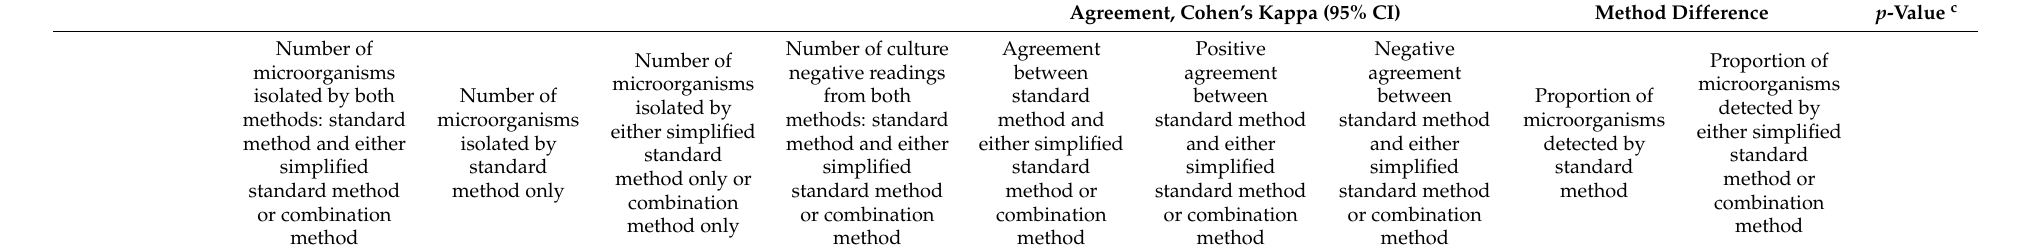
Table 3. Agreement and differences on a microbial level between the standard corneal culture method and two modified methods, a simplified standard method and a combination method, in patients with infectious